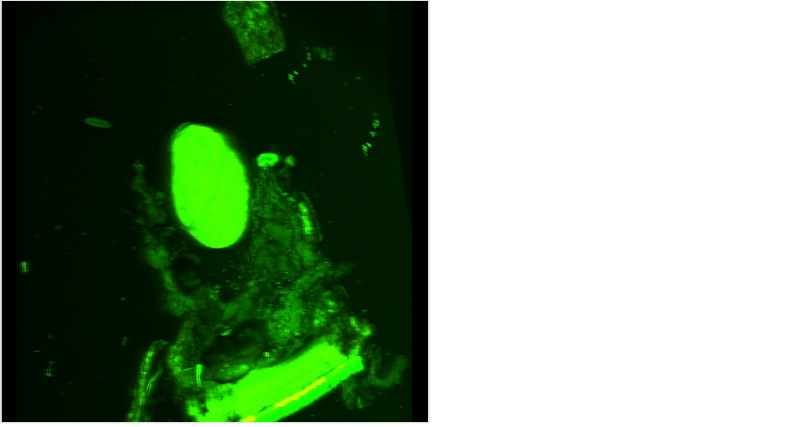
CLSM volume rendered media fi le showing the cyanide gland of Oxidus gracilis (gland extract is the overexposed droplet).